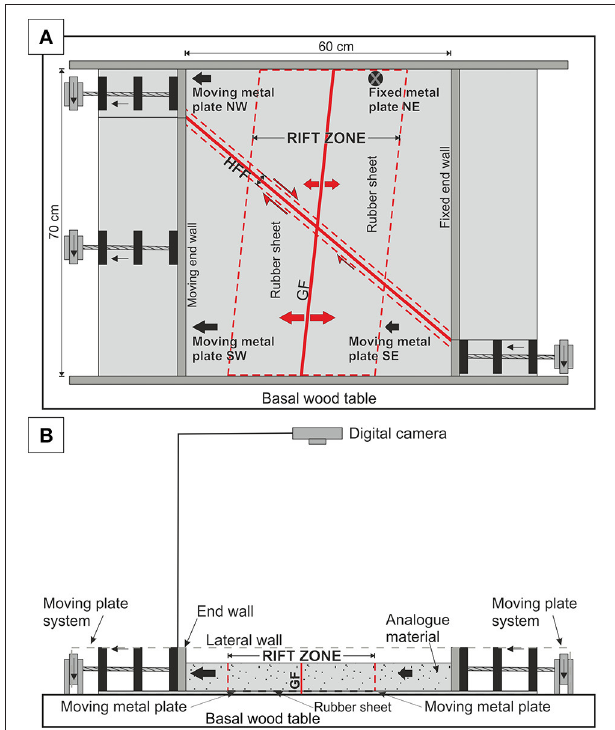
FIGURE 7 | Sketch of the experiment apparatus: above in plan view and below in section view. (A) Three out of four plates can move together or singularly. (B) The angle α indicates the amount of transtension. The arrows indicate the vs. of plate movement and their dimension is proportional to the relative slip